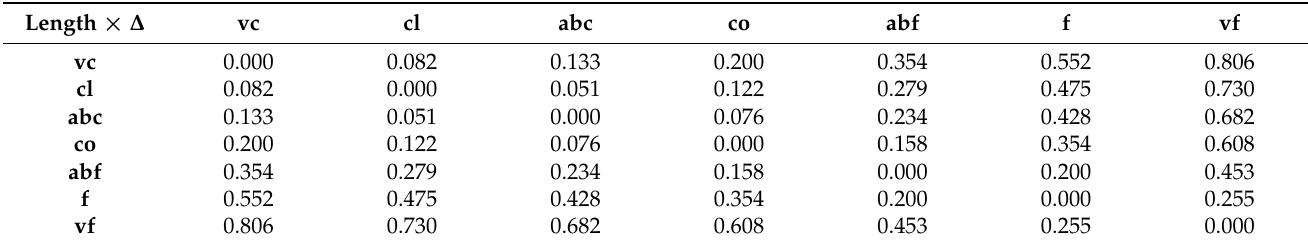
Table 9. Distance relation